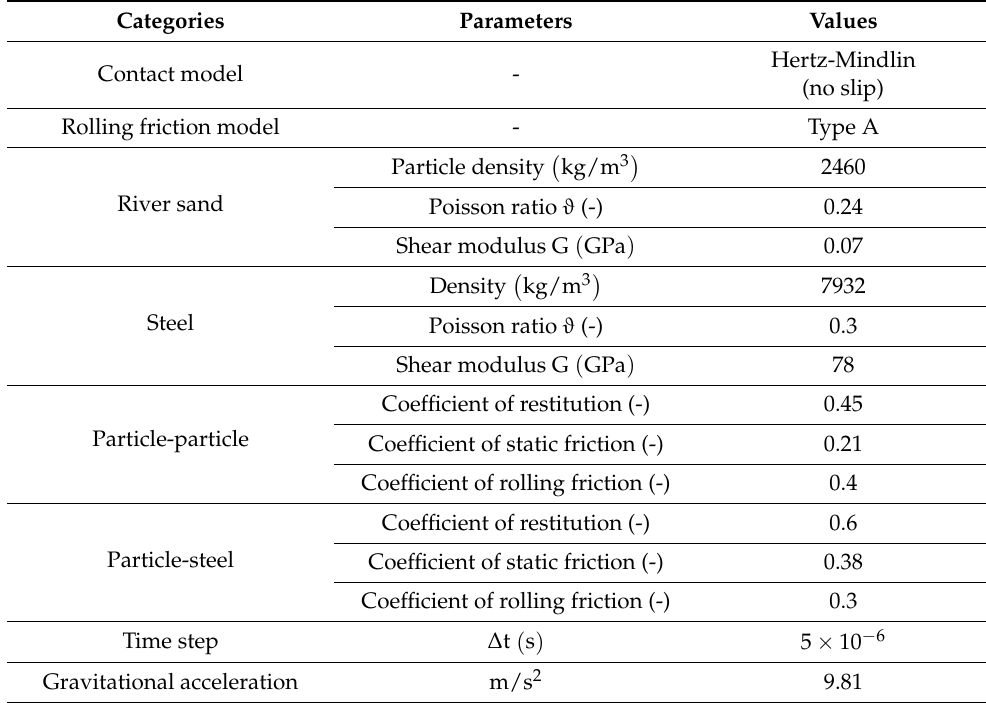
Figure 2. Particle size distribution. Table 1. General DEM parameters. Table 1. General DEM